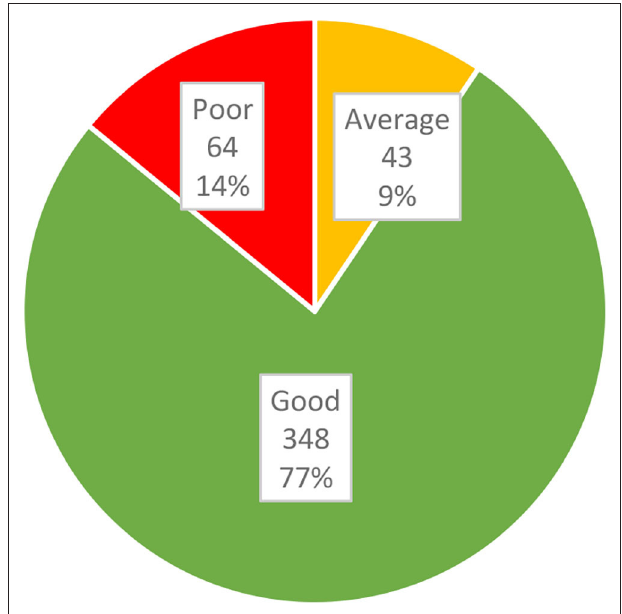
FIGURE 1 | Categories of caregivers’ knowledge ( n = 455).